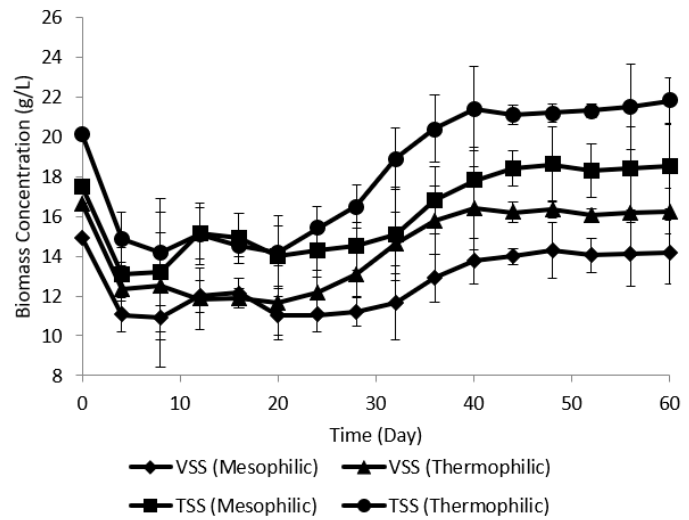
Figure 4. The range of VSS and TSS for thermophilic and mesophilic conditions during the acclimatization period. Notes: error bars show standard deviation of means (n = 3).